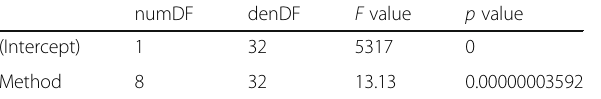
Table 3 A p value of zero indicates that the ANOVA test used is significant and refutes the hypothesis that all methods tested are similar numDF denDF F value